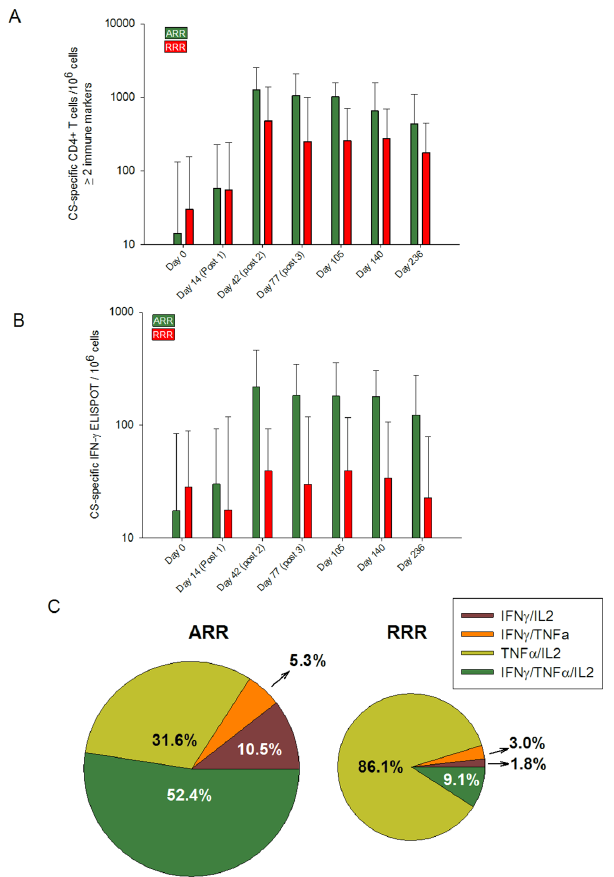
Fig 3. Cellular immune responses by vaccine group and days post immunization. A. Geometric mean CS-specific CD4 + T cells producing IFN- γ by ELISpot. Comparisons between ARR and RRR on days 42, 77, 105,140, and 236 were significant (P < .05) by Student ’ s t -test on log-transformed data. Error bars represent standard deviation of the mean. B. Geometric mean CS-specific CD4 + T cell responses expressing (cid:3) 2 cytokine/activation markers among IL2, IFN- γ , TNF- α , and CD40L, per million PBMC. Comparisons between ARR and RRR on days 42, 77, 105, 140 were significant (P < .05) by Student ’ s t -test on log-transformed data. Error bars represent standard deviation of the mean. C. Pie charts showing the pattern of CS-specific polyfunctional CD4 + CD40L + T cells expressing (cid:3) 2 cytokine markers at Day 77 (day of challenge). Each slice within the pie chart represents a specific combination of two or three cytokines. The size of the pie chart is proportional to the magnitude of the response.